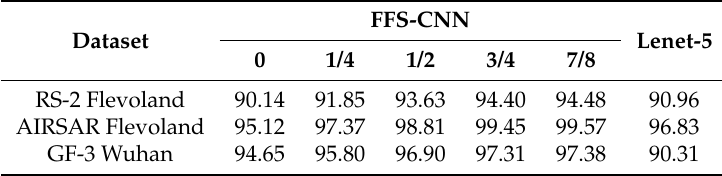
Table 8. The relationship between overlap ratio and OAs (%).